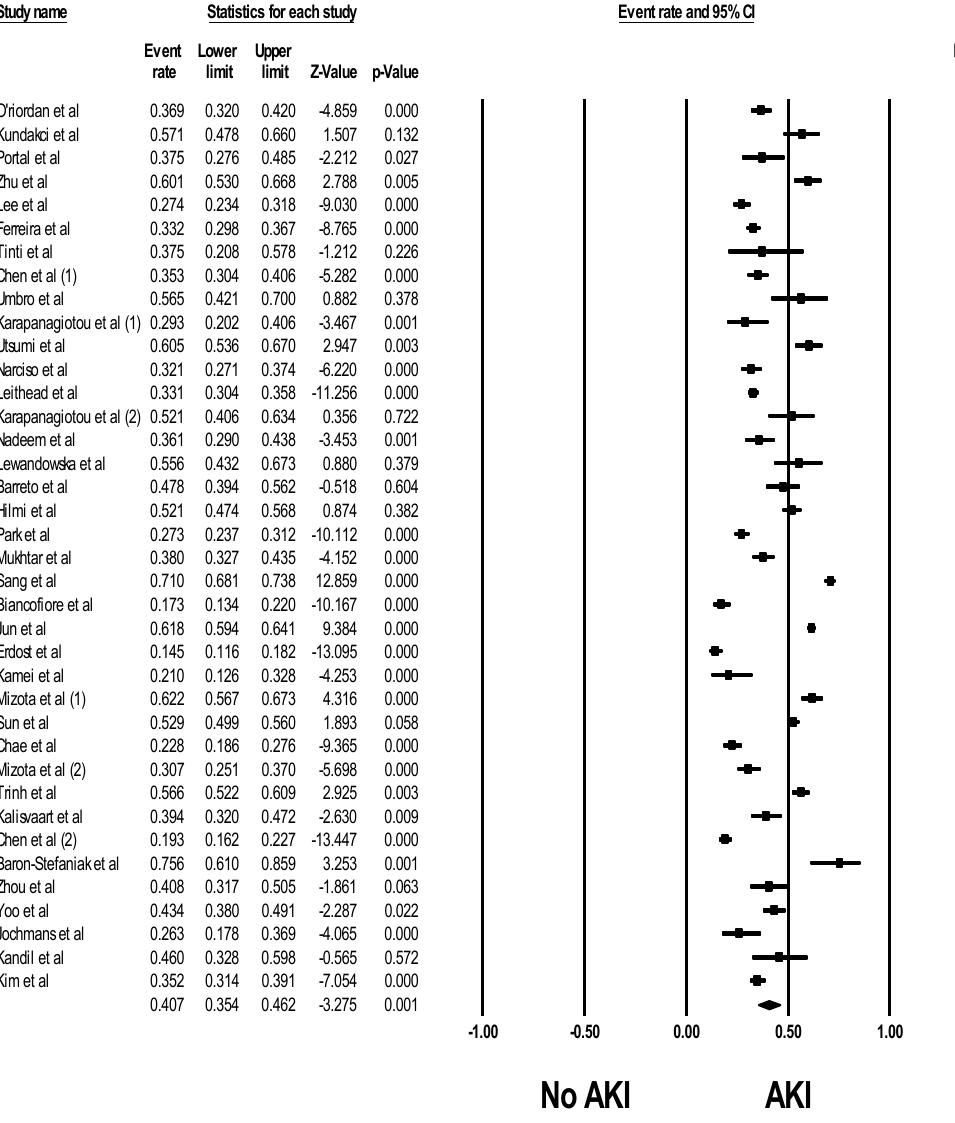
Figure 2. Forest plots of the included studies assessing incidence rates of post-LTx AKI. A diamond data marker represents the overall rate from each included study (square data marker) and 95% confidence interval.